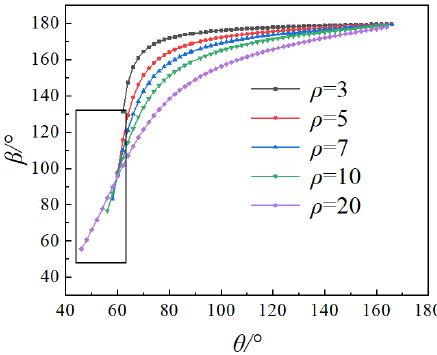
Figure 8. The curves of different ρ at λ = 0.5.